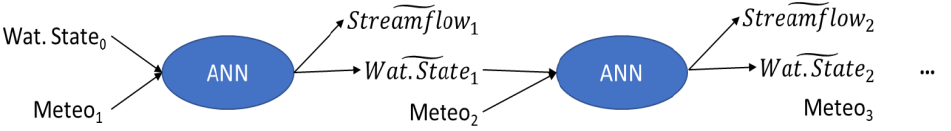
Figure 5. Schematic representation of the forecast chain used (example for forecasts one and two days in advance and exactly represented 2-SMP and 3-dSMP with update of watershed state variable at each time step). The tilde represents outputs of the ANN model. The index represents the forecast horizon day, with 0 the day of forecasting.